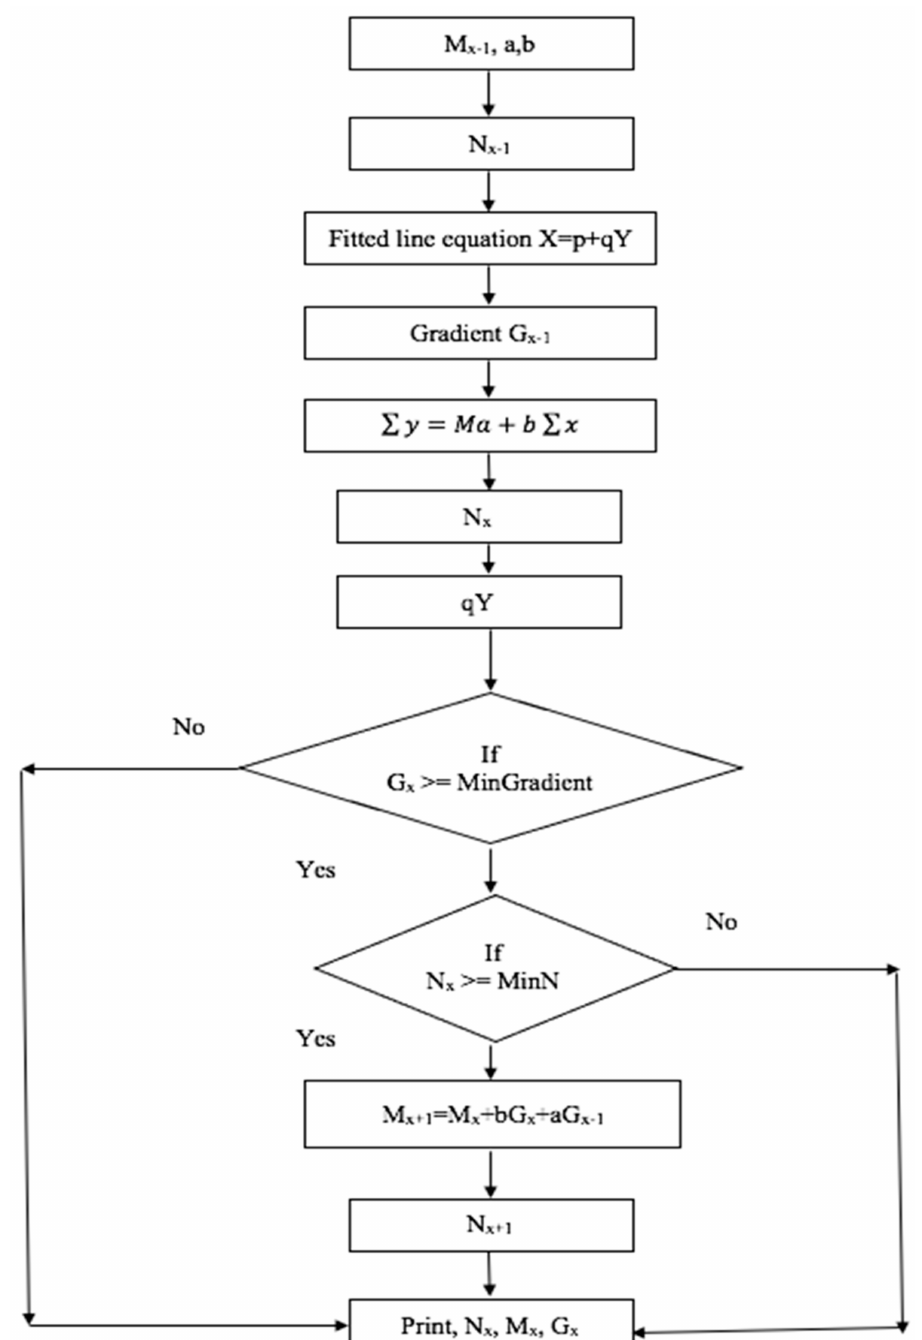
Figure 3. HNADAM-SGD flow